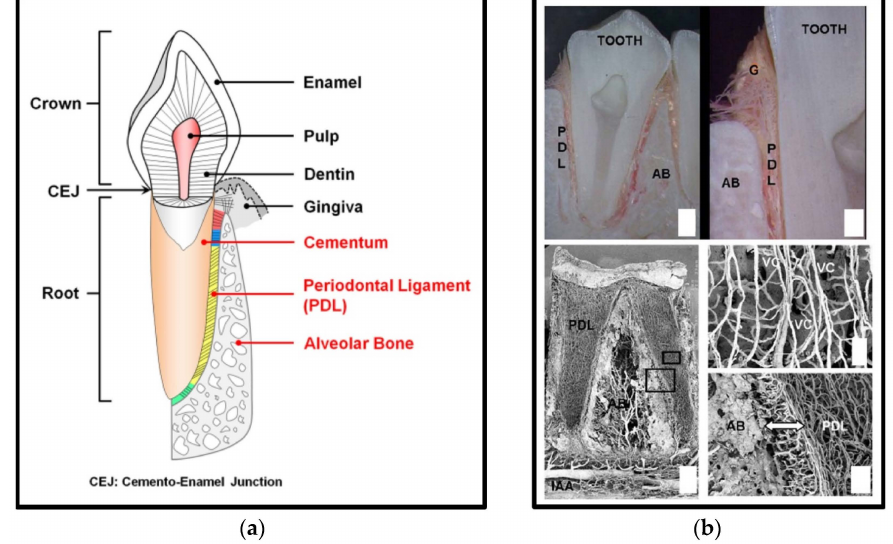
Figure 1. Anatomical schematic illustration of the periodontal tissue complex and the structure of periodontal tissues ( a ). ( b ) Periodontal ligament (PDL), alveolar bone (AB), gingiva (G), inferior alveolar artery (IAA), Volkmann’s canals (VC)